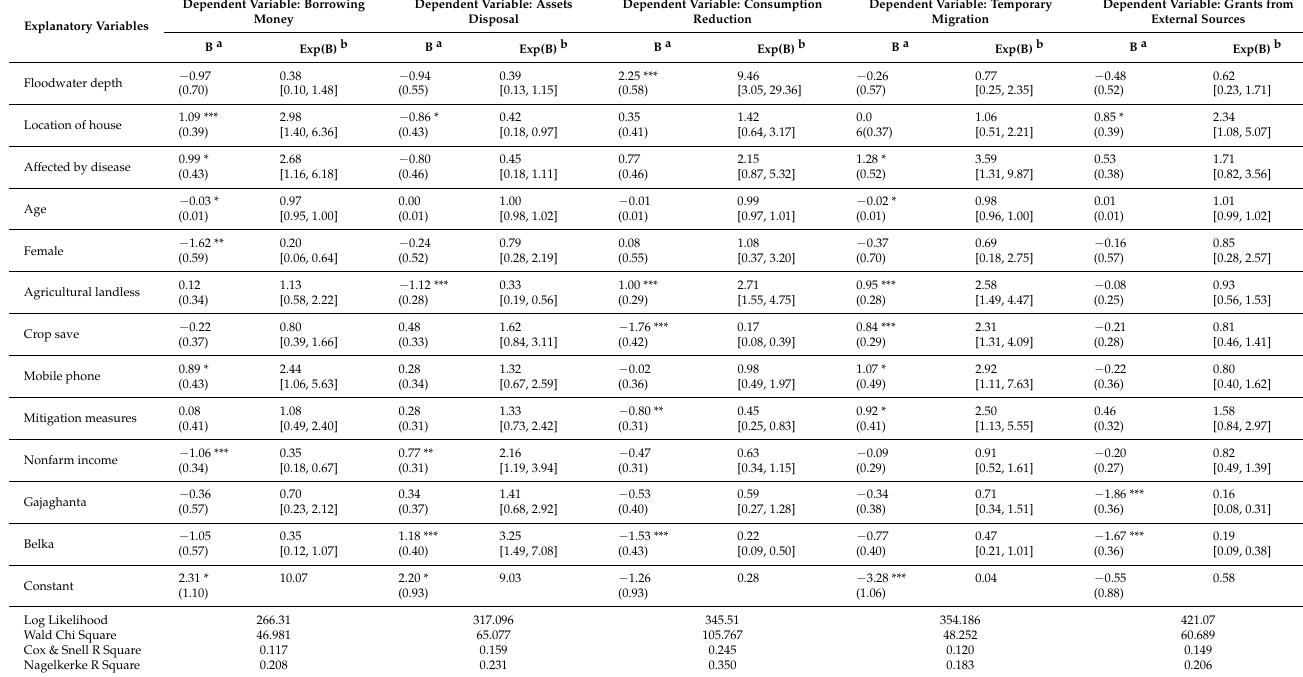
Table A2. Details of the Determinants of Post-Disaster Coping Strategies.